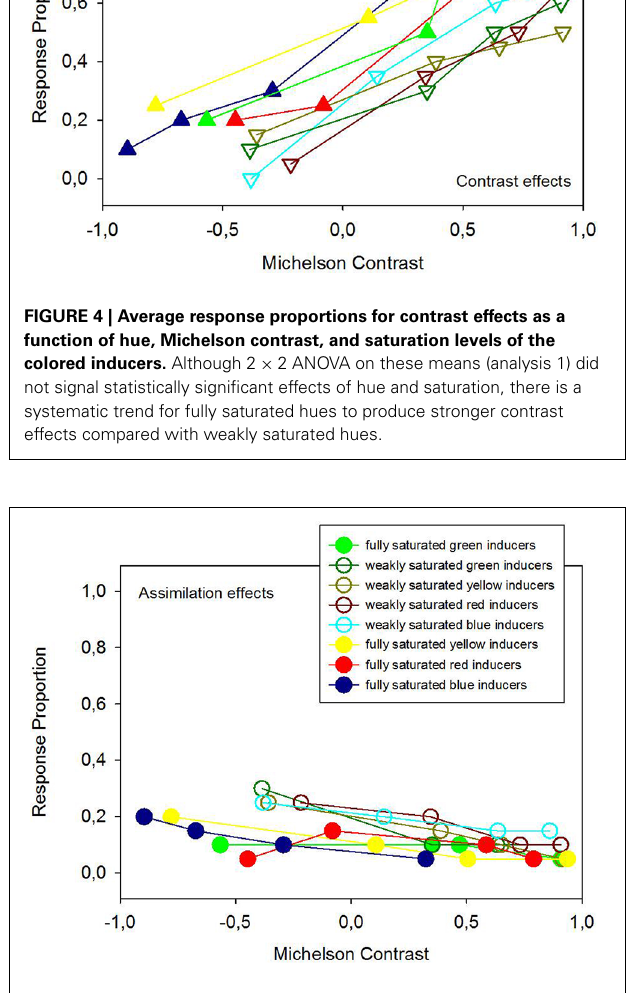
FIGURE 5 | Average response proportions for assimilation effects as a function of hue, Michelson contrast, and saturation levels of the colored inducers. Although 2 × 2 ANOVA (analysis 1) did not signal statistically significant effects of hue and saturation, there is a systematic trend for weakly saturated hues to produce stronger assimilation effects compared with fully saturated hues.